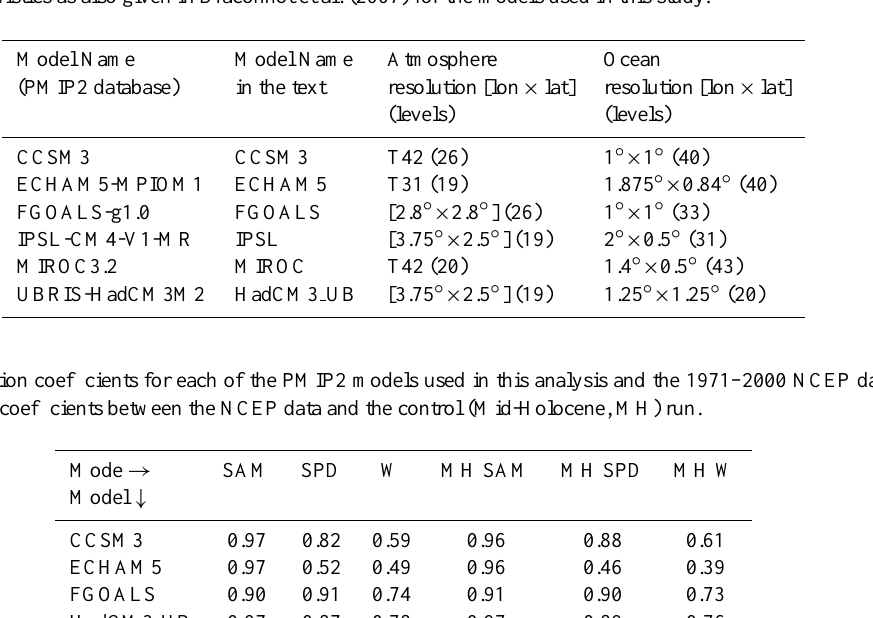
Table 1. Model characteristics as also given in Braconnot et al. (2007) for the models used in this study.